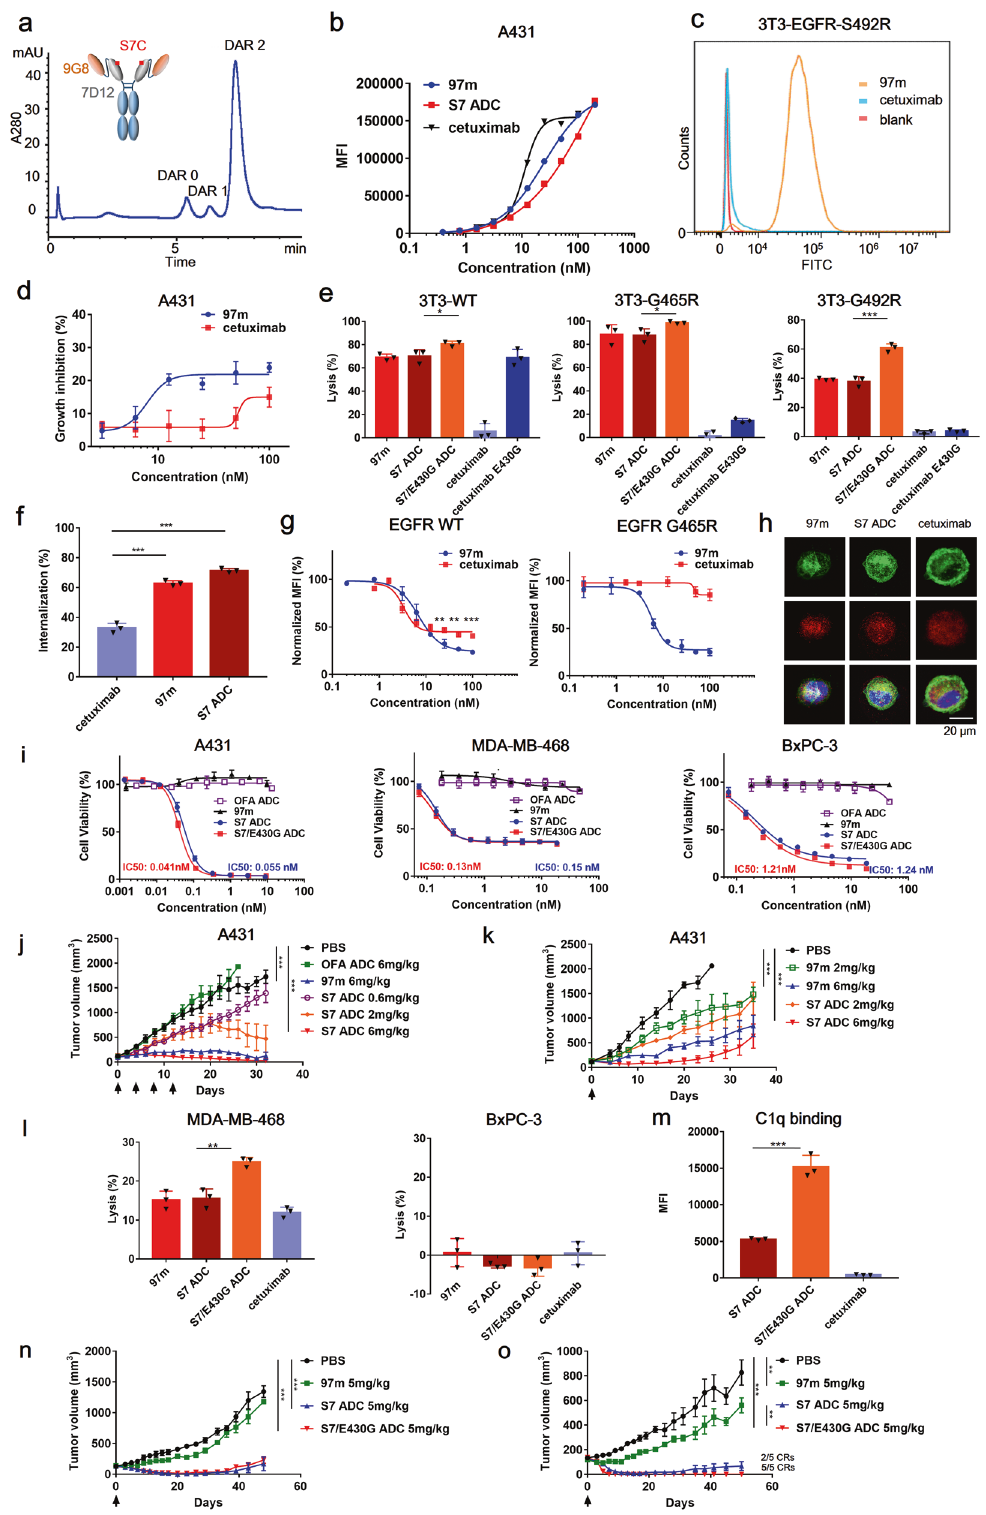
the cytotoxicity of drug payload during cancer treatment. We also evaluated the CDC activity of antibody on another two EGFR- positive tumor cell lines, MDA-MB-468 and BxPC-3. BxPC-3 was used as a negative control cell. Since it is a complement-insensitive cell line with high expression of CD59, which is a membrane protein Signal Transduction and Targeted Therapy (2021)